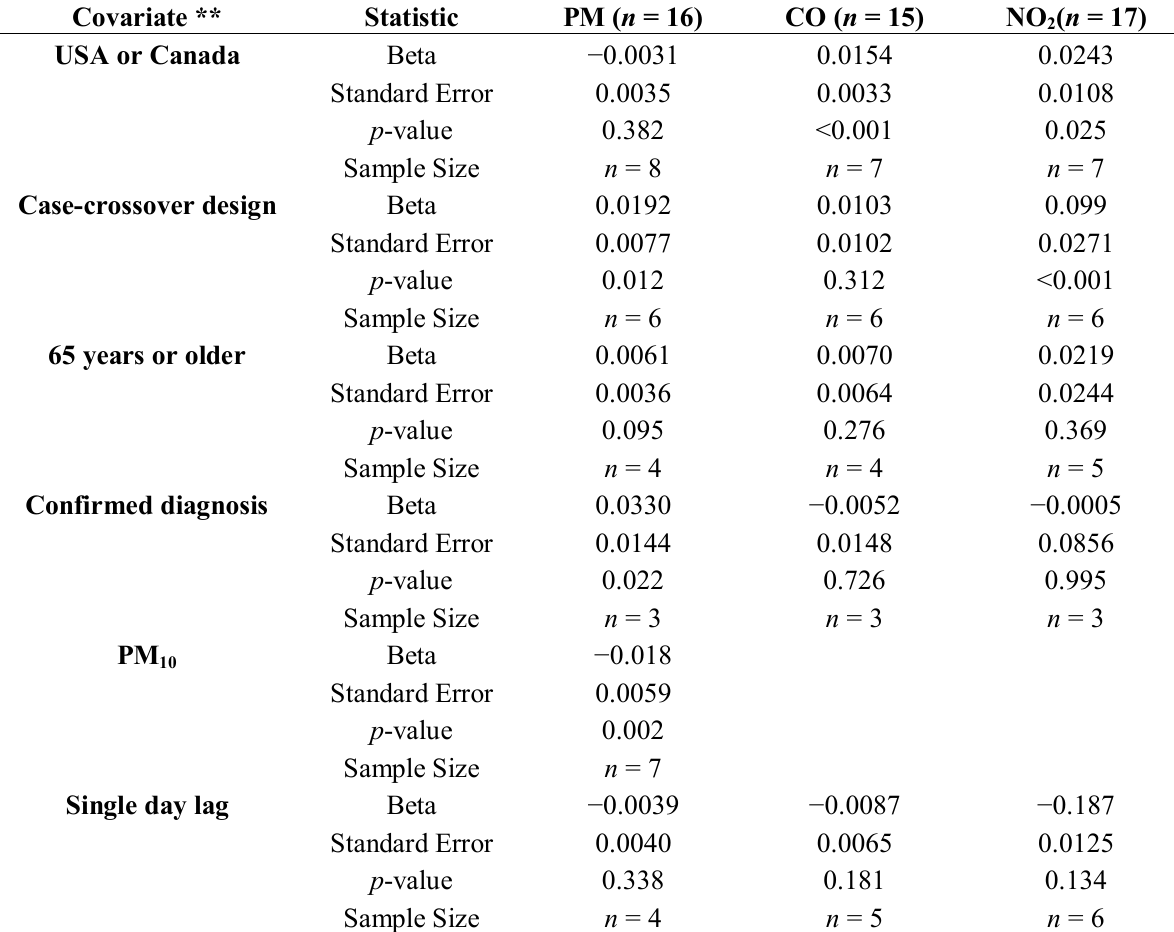
Table 2. Results of the meta-regression models for studies of Ischemic Heart Disease (IHD)*. Beta coefficients indicate the increase or decrease in the log RR that depends on the